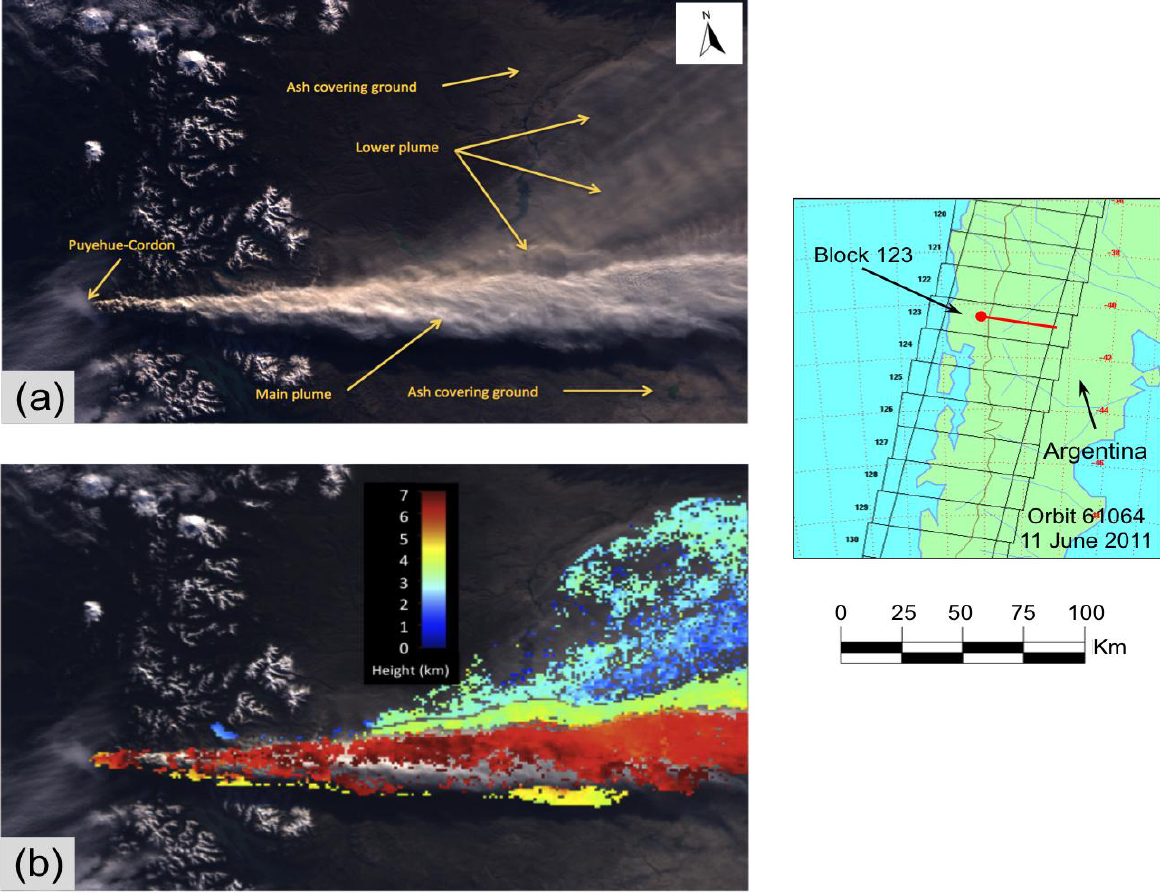
Figure 14. The 11 June 2011, eruption of Puyehue-Cordon in Chile on orbit 61064, block 123: ( a ) Nadir image of eastward trending main plume, lower plume being blown toward the northeast, and ash-covered ground; ( b ) heights retrieved for the main plume reach 7 km and the secondary plume lies below 3